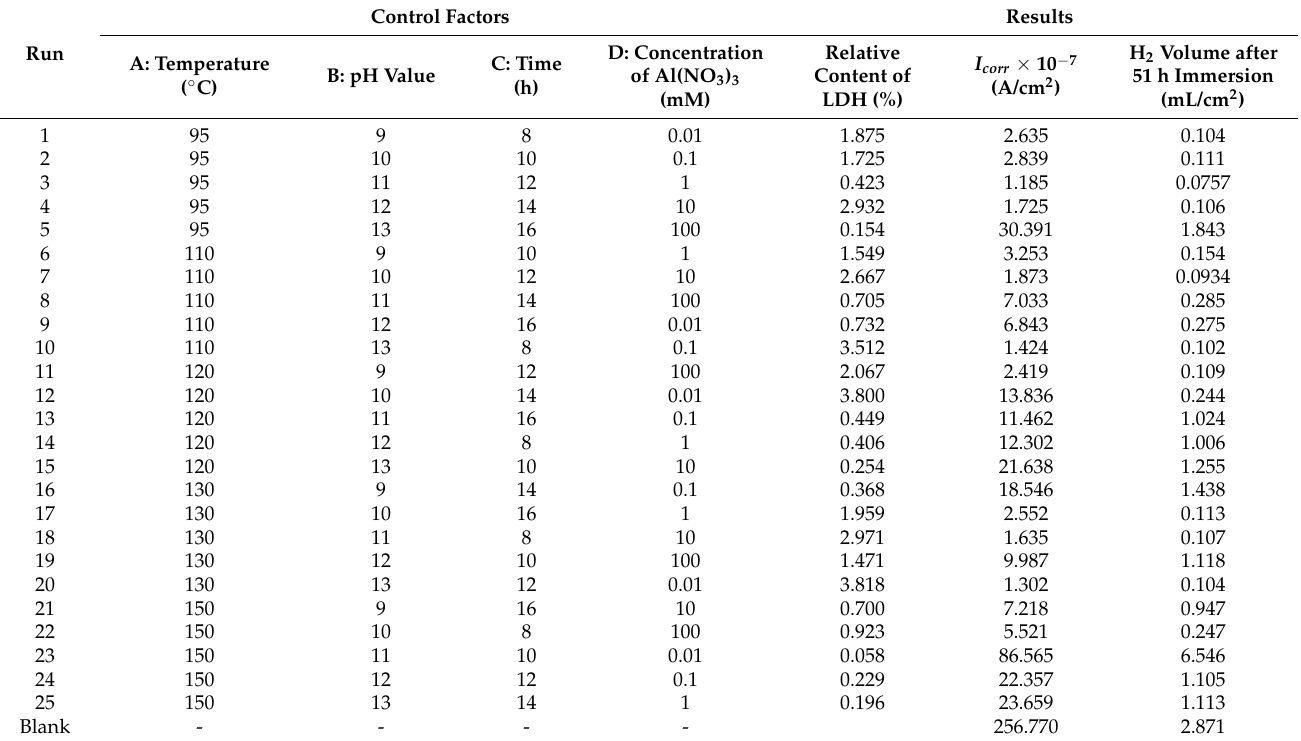
Table 2. Design and results of the orthogonal array with, factor 5 and level 4 in Table